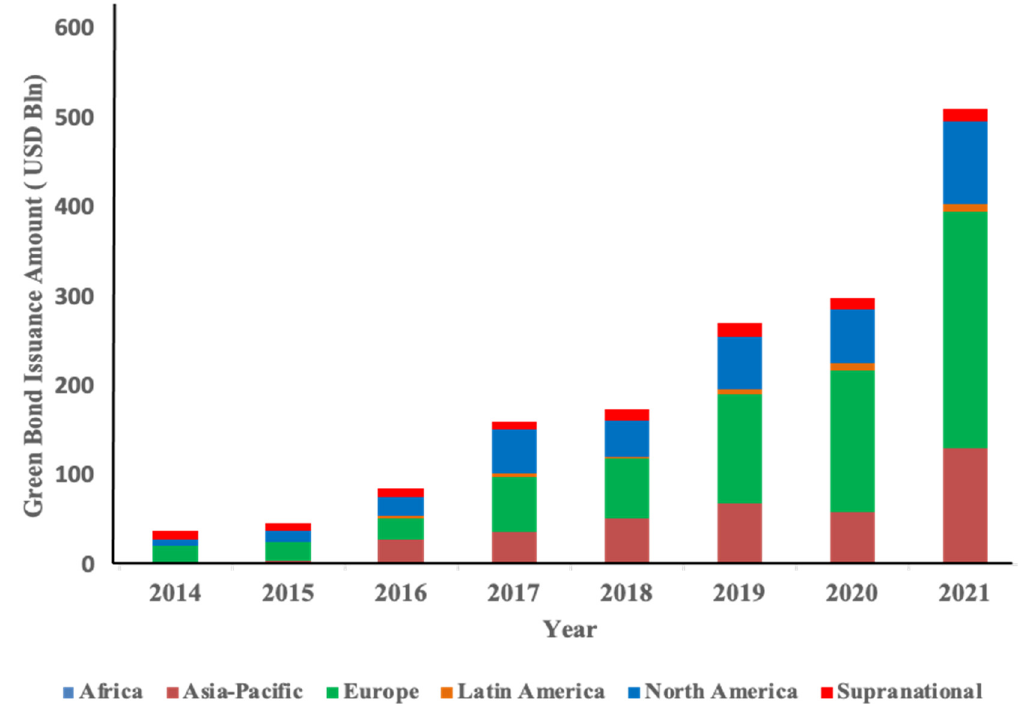
Figure 1. Global Green Bond Issuance by Regions. Prepared by the authors based on data from CBI (2021a).